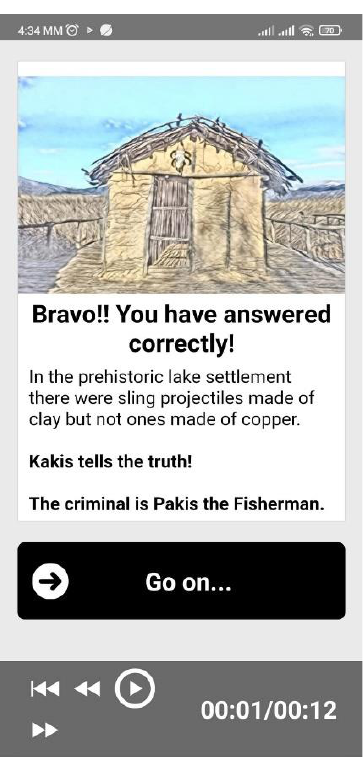
Figure 15. Feedback.